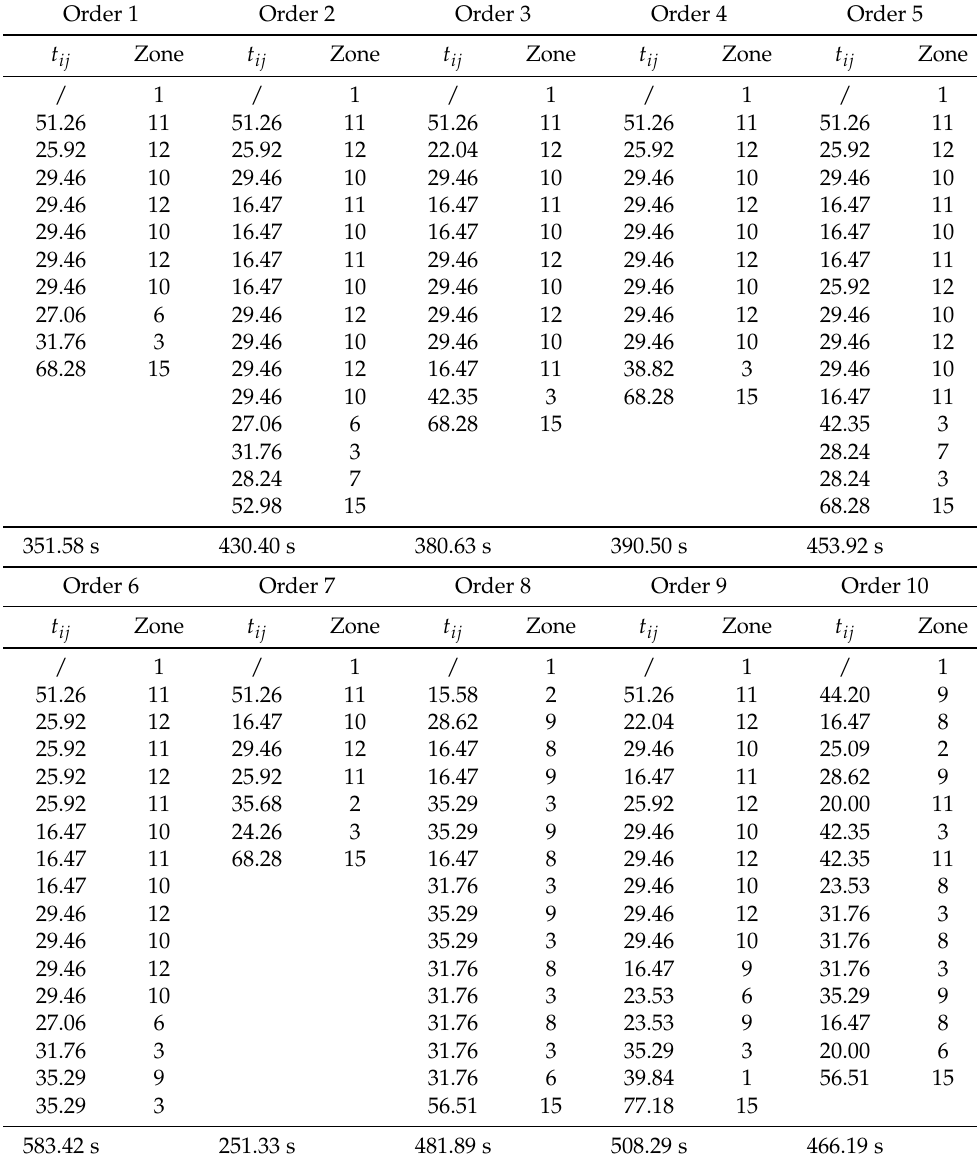
Table 2. Simulation of travel times for 10 BOPS orders when no optimization is